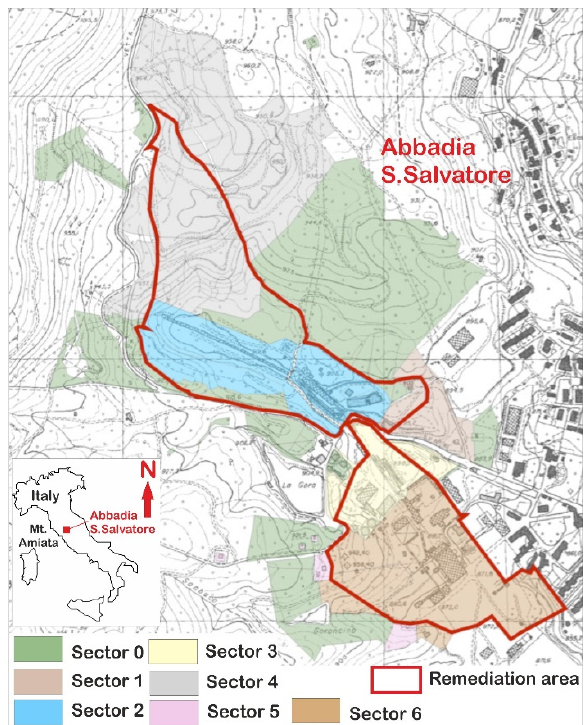
Figure 1. Location of the Hg-mining district of Abbadia San Salvatore (Central Italy) and the seven sectors into which the mining are was divided according to the different reclamation activities (modified from [24]). Scale 1:15,000.